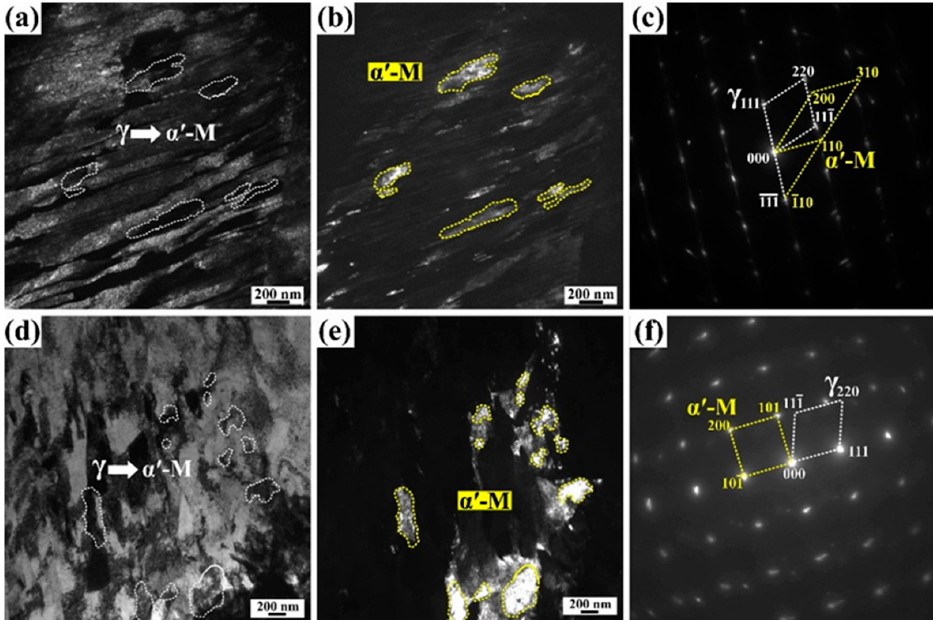
Figure 5. TEM micrographs of Cr19 series DSS near the fracture surface after solution treatment at 1050 °C for 5 min, ( a ) bright field image of α′ -M in Cr19 DSS, ( b ) dark field image of α′ -M in Cr19 DSS, and ( c ) corresponding TEM SADP; ( d ) bright field image of α′ -M in Cr19 + W DSS, ( e ) dark field image of α′ -M in Cr19 + W DSS, and ( f ) corresponding TEM SADP.